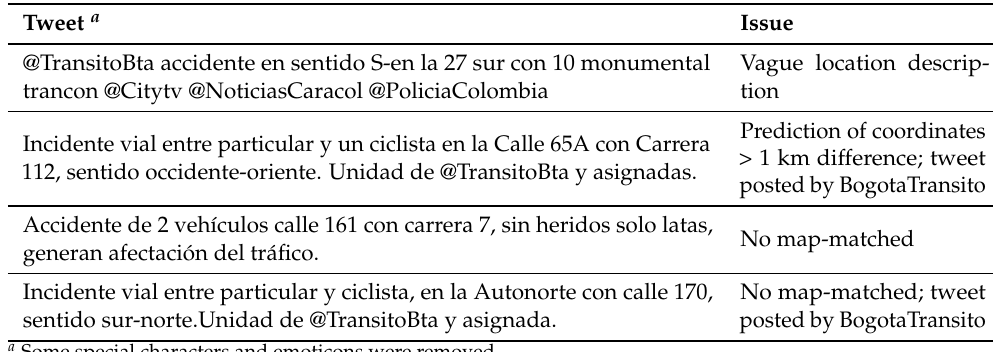
Table 18. Tweets not map-matched by accident official